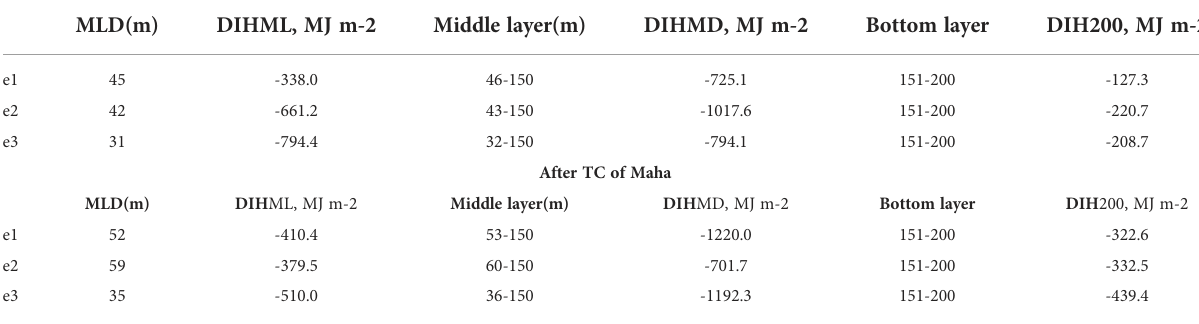
TABLE 5 Depth integrated heat